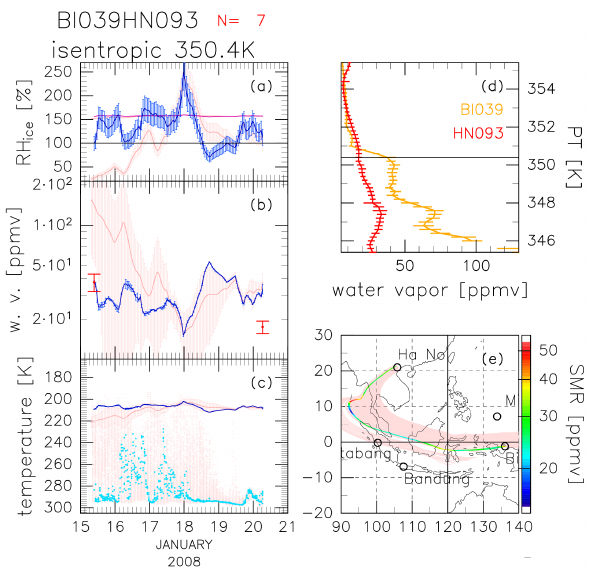
Fig. 7. As for Fig. 5 but for the match that advected from Biak (09:46UT, 15 January 2008) to Hanoi (06:45UT, 20 January 2008) at the 350.4K potential temperature surface with an advection time of about 5 days.